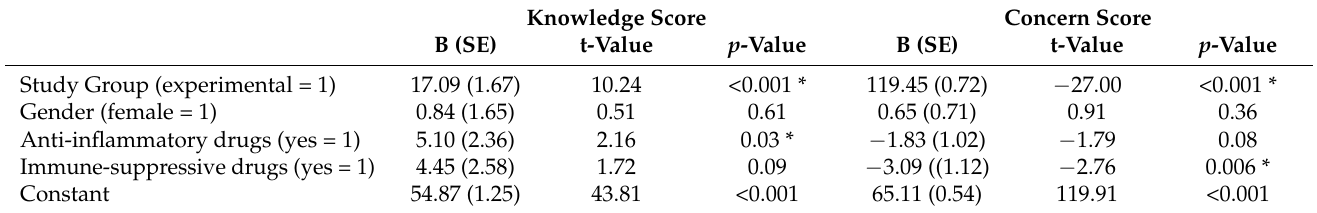
B—coefficient of determination, SE—standard error, *—statistical